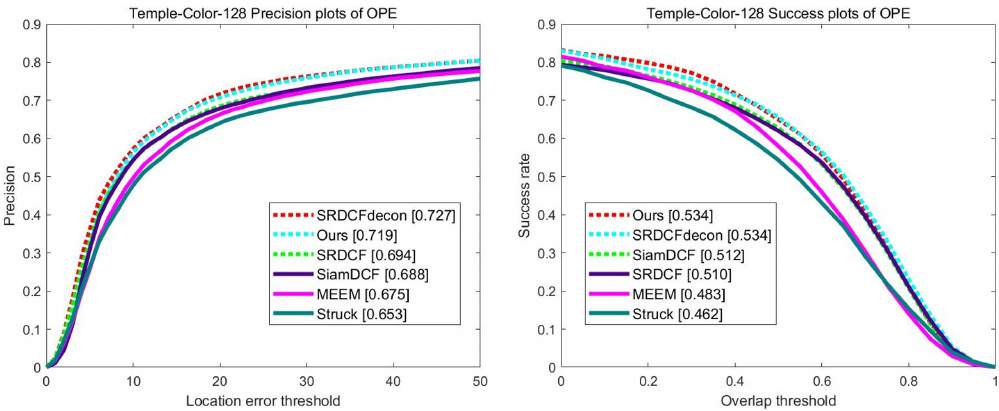
Figure 11. The precision and success rate overall sequences by using one-pass-evaluation on the TempleColor-128